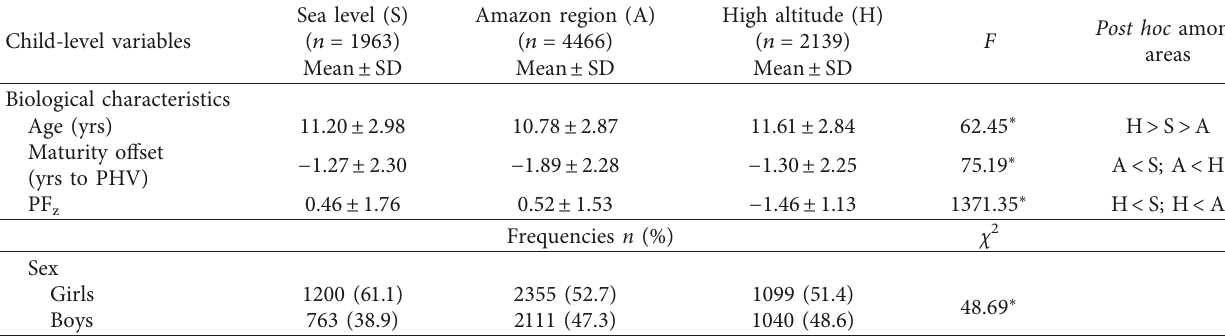
Table 4: Descriptive statistics for child-level variables.